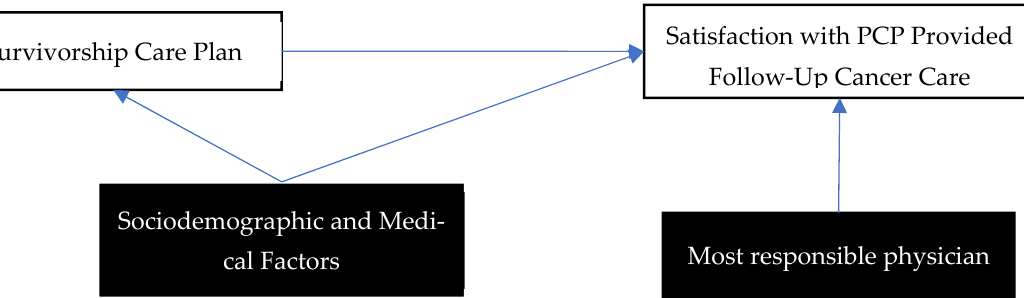
Figure 1. Directed Acyclic Graph on the Relationship between SCP and Satisfaction with PCP Delivered Follow-Up Cancer Care.